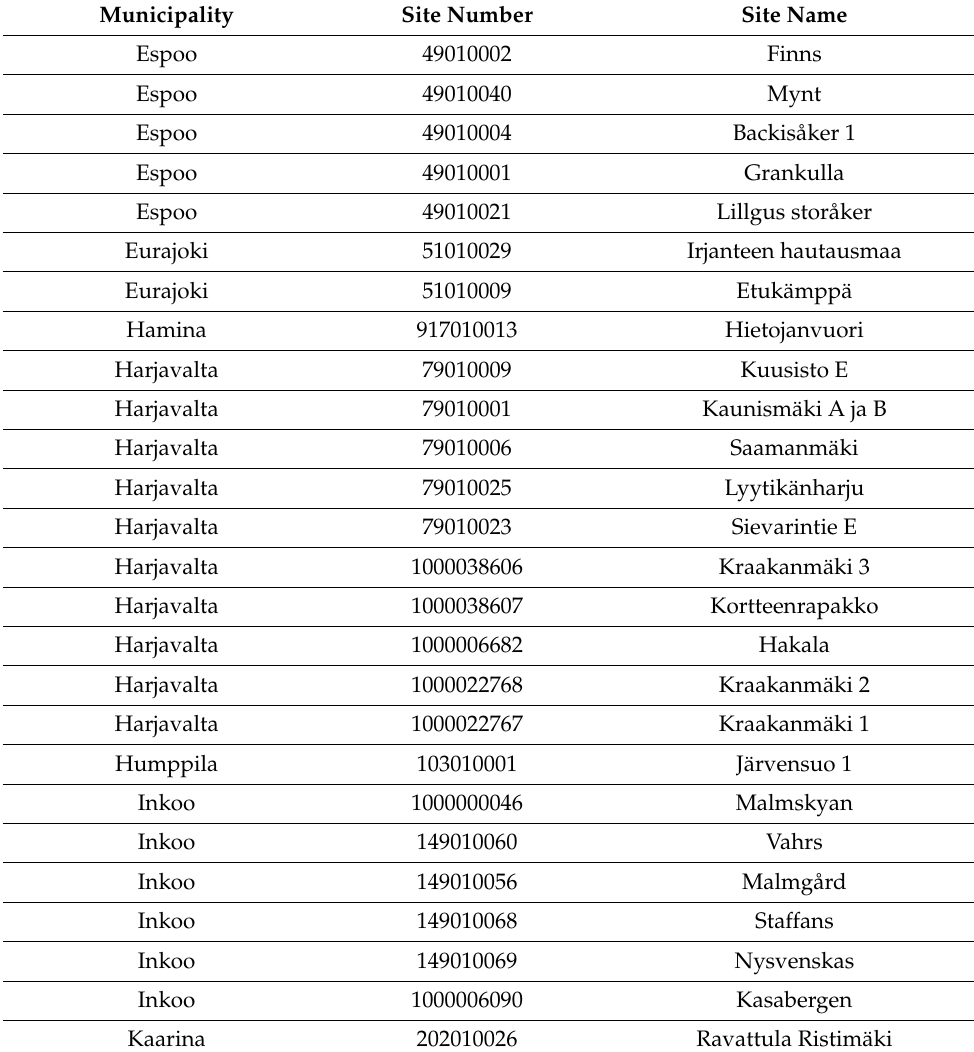
Table A1. The list of archaeological sites where Kiukainen pottery has been found and discussed in this